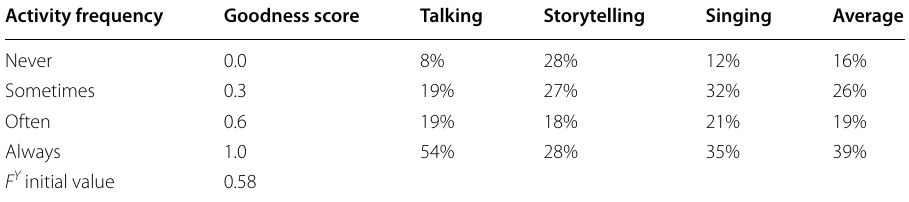
Table 6 Percentage of children receiving cognitive stimulation in Quintiles 1–3 Activity